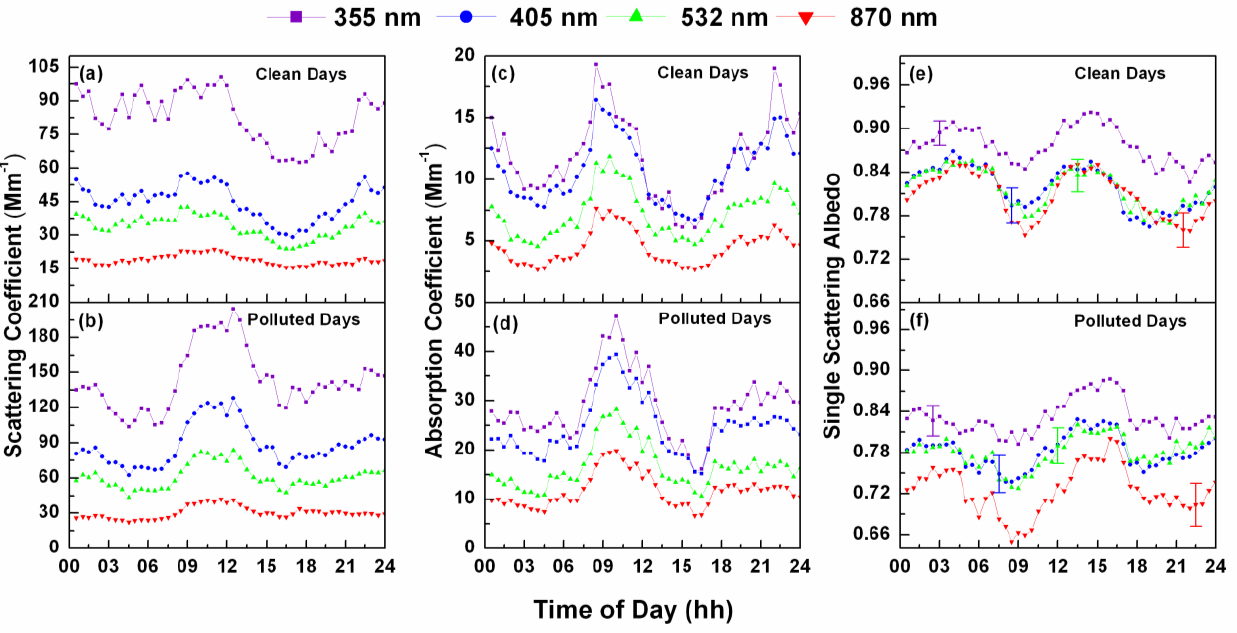
Fig. 6. Diurnal variation of half-hour average ambient aerosol optical properties from 18 December 2009 to 18 January 2010 at wavelengths 355, 405, 532, and 870nm for clean and polluted days. (a) and (b) are the scattering coefficients, (c) and (d) are the absorption coeffi- cients, and (e) and (f) are the single scattering albedos (SSA). Uncertainty on SSA was determined by assuming 5% relative uncertainty in photoacoustic absorption coefficient measurements and 15% relative uncertainty in scattering coefficient